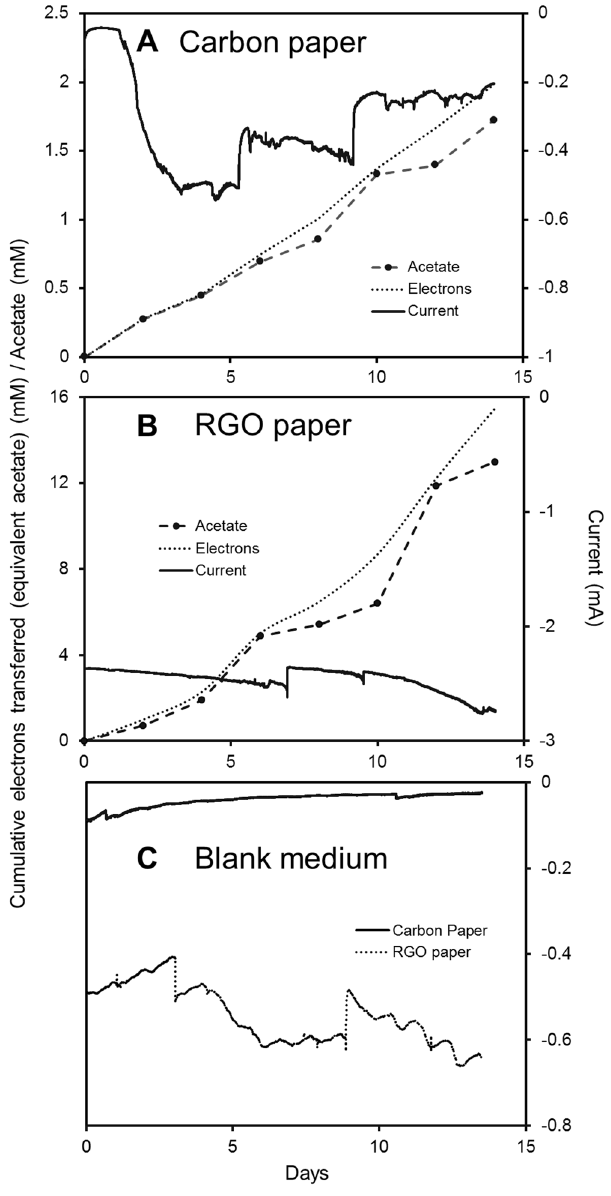
Figure 2. Acetate concentration, electron transferred and current consumption during MES with ( A ) a carbon paper cathode or ( B ) a RGO paper cathode. ( C ) Current consumption with carbon paper cathode or RGO paper cathode in sterile medium. The acetate concentration in mM corresponds to the analytical concentration of acetate in the reactor measured from high-pressure liquid chromatography (HPLC). Electron transferred curves measured from potentiostat refer to the acetate concentration in mM if all the electrons transferred were converted to acetate in the system. Results shown are from a representative example of three replicate bioelectrochemical